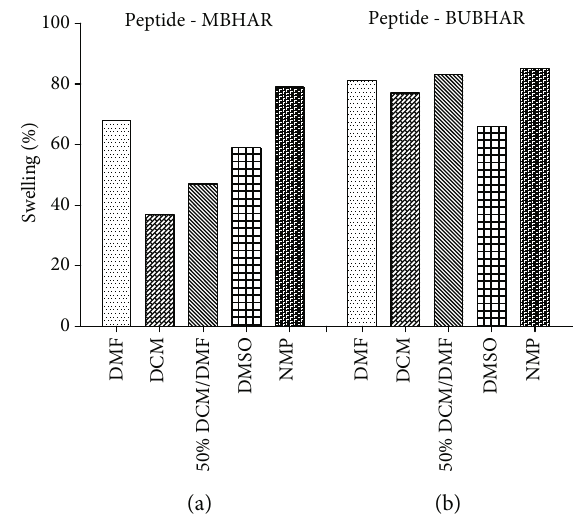
Figure 1: Swelling degree values (in percentage) of Asn-Cys- Pro-(D-Arg)-Gly fragment bound to methylbenzhydrylamine resin (MBHAR) (a) and to 4- tert -Butyl-benzhydrylamine resin ( BUBHAR) (b) in di ff erent